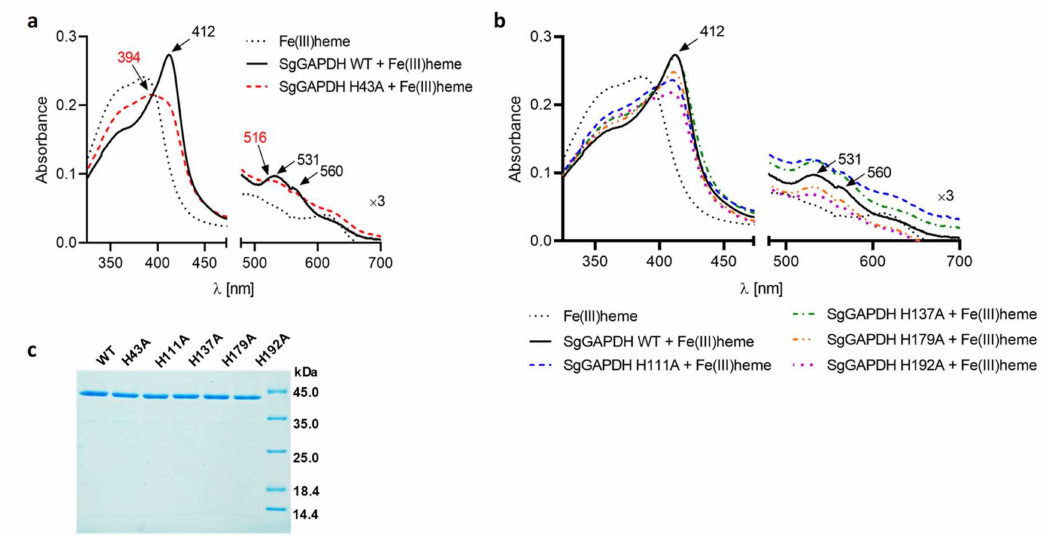
Figure 4. Heme binding to SgGAPDH site-directed mutagenesis protein variants. UV-visible spectra recorded for 5 µ M ( a ) His43Ala or ( b ) His111Ala, His137Ala, His179Ala, and His192Ala protein variants in complex with 4 µ M Fe(III)heme are shown. ( c ) Confirmation of equal protein amount in all samples was examined by SDS-PAGE and CBB G-250